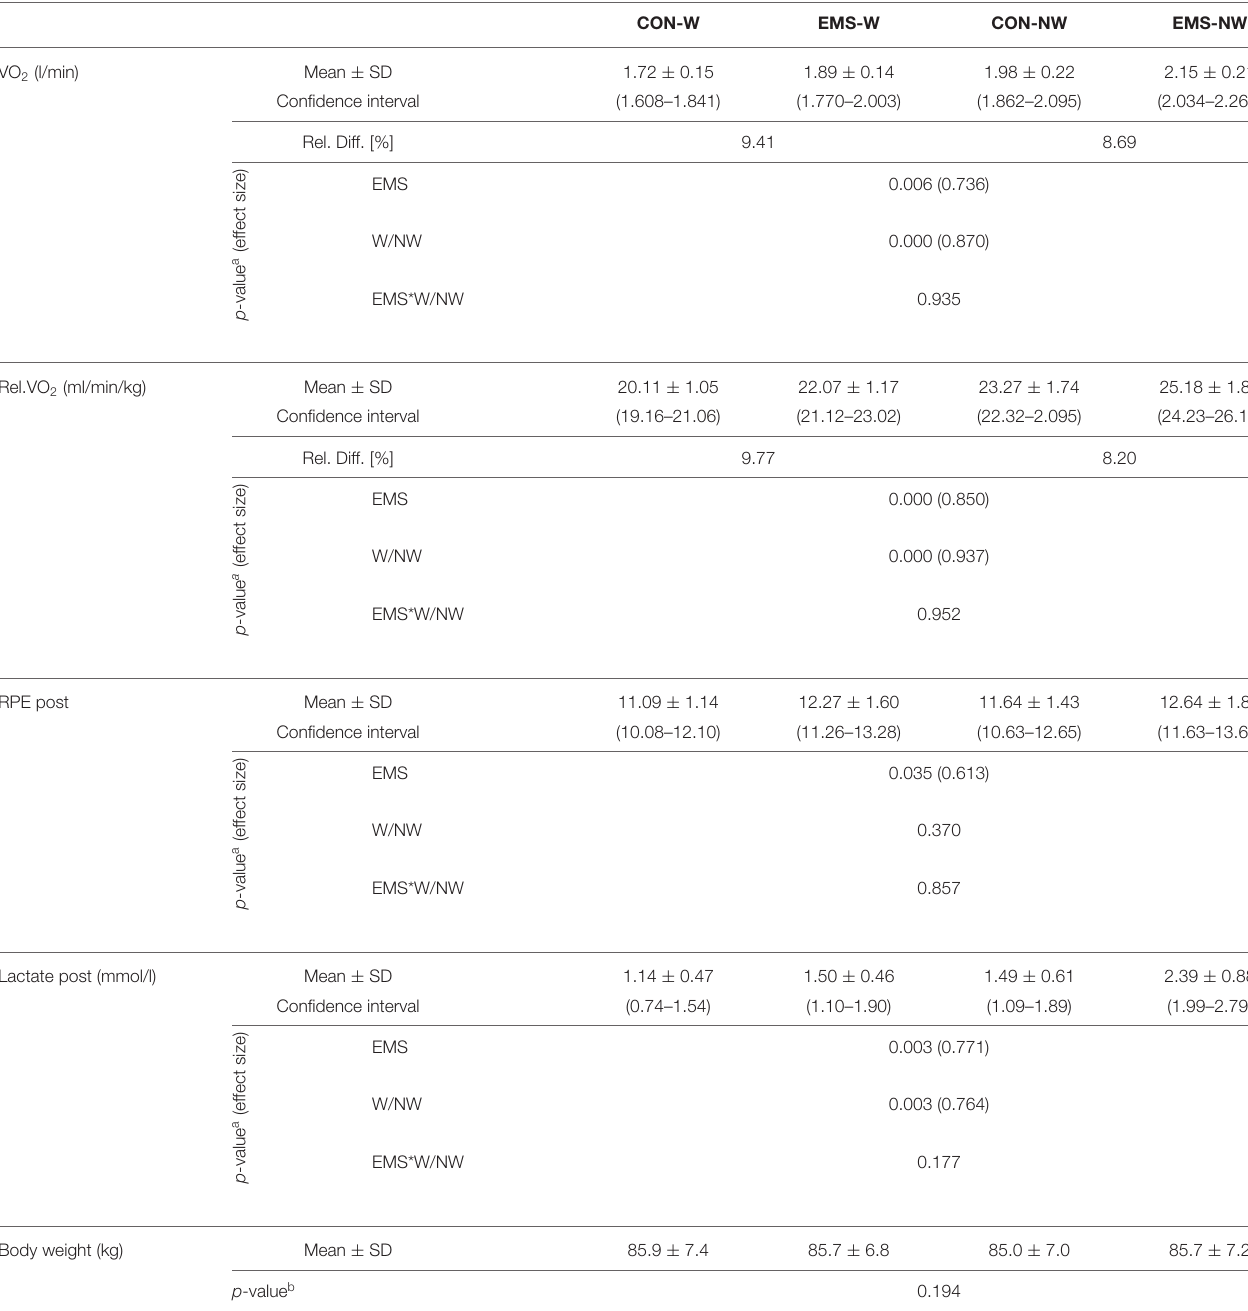
TABLE 1 | Result for the body weight, absolute (VO 2 ) and relative VO 2 (rel.VO 2 ; in relation to body weight) oxygen intake, rate of perceived exhaustion (RPE; Borg-scale), and post-exercise blood lactate concentration of the outcome